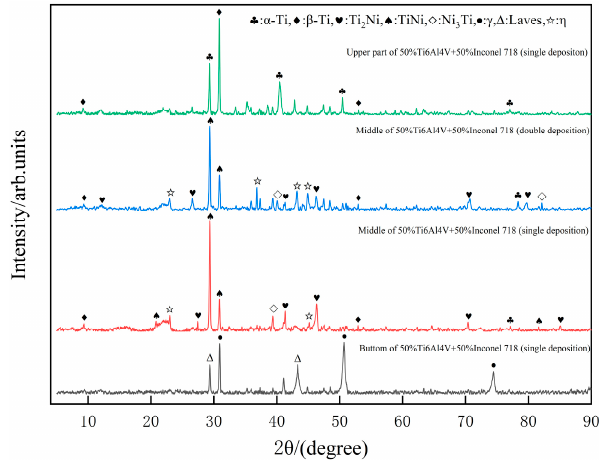
Figure 3. XRD di ff raction pa tt ern of single-layer samples. Figure 3. XRD diffraction pattern of single-layer